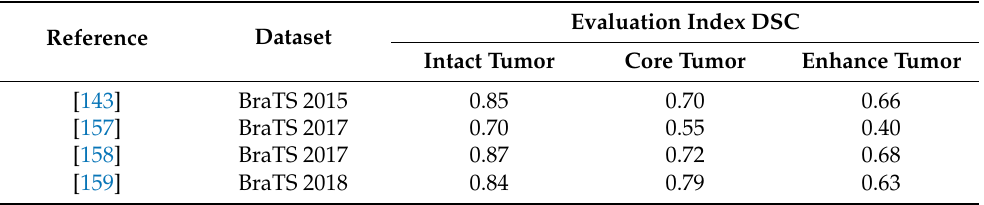
Evaluation Index